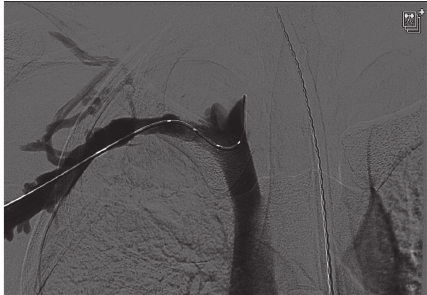
Figure 4: Angiogram revealing contrast flow through the subcla- vian vein status after catheter-directed thrombolysis and balloon angioplasty of the subclavian and axillary